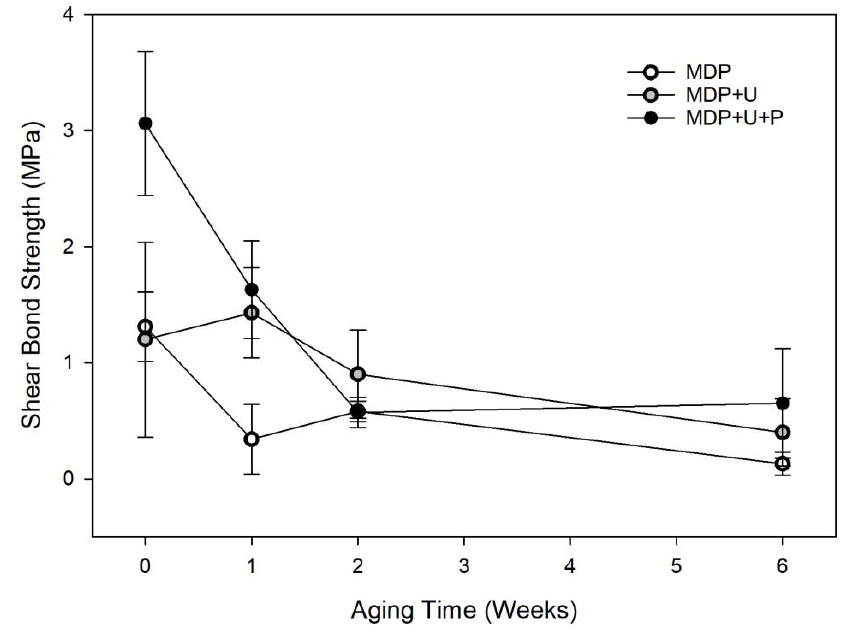
Figure 2. Shear strength of adhesive formulations during 6-week artificial aging study. The symbols represent the mean shear bond strength with error bars representing the SD.